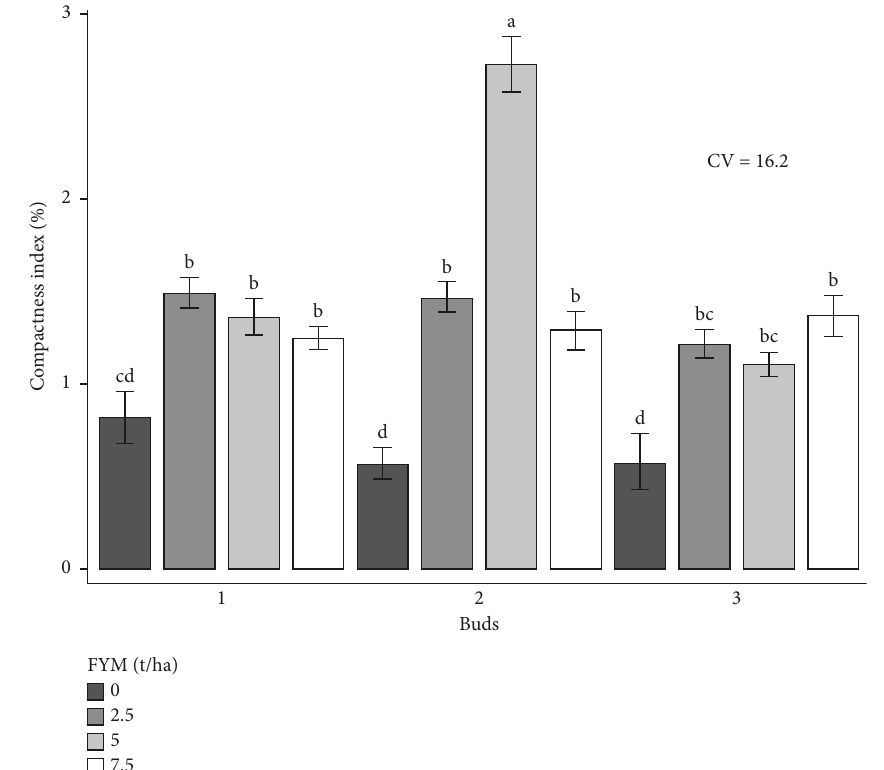
Figure 6: Compactness index as influenced by the interaction effect of bud numbers and farmyard manure fertilizer